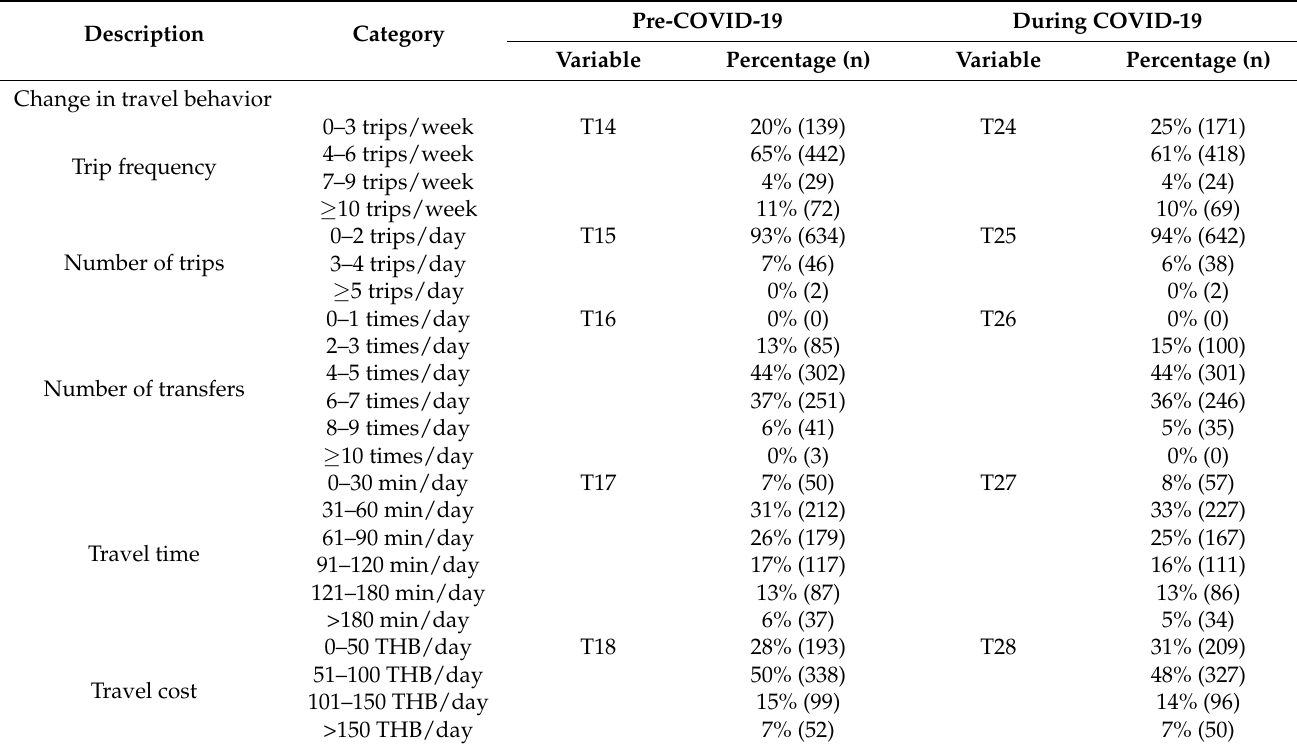
Table 3. Characteristics of behavior changes respondents.